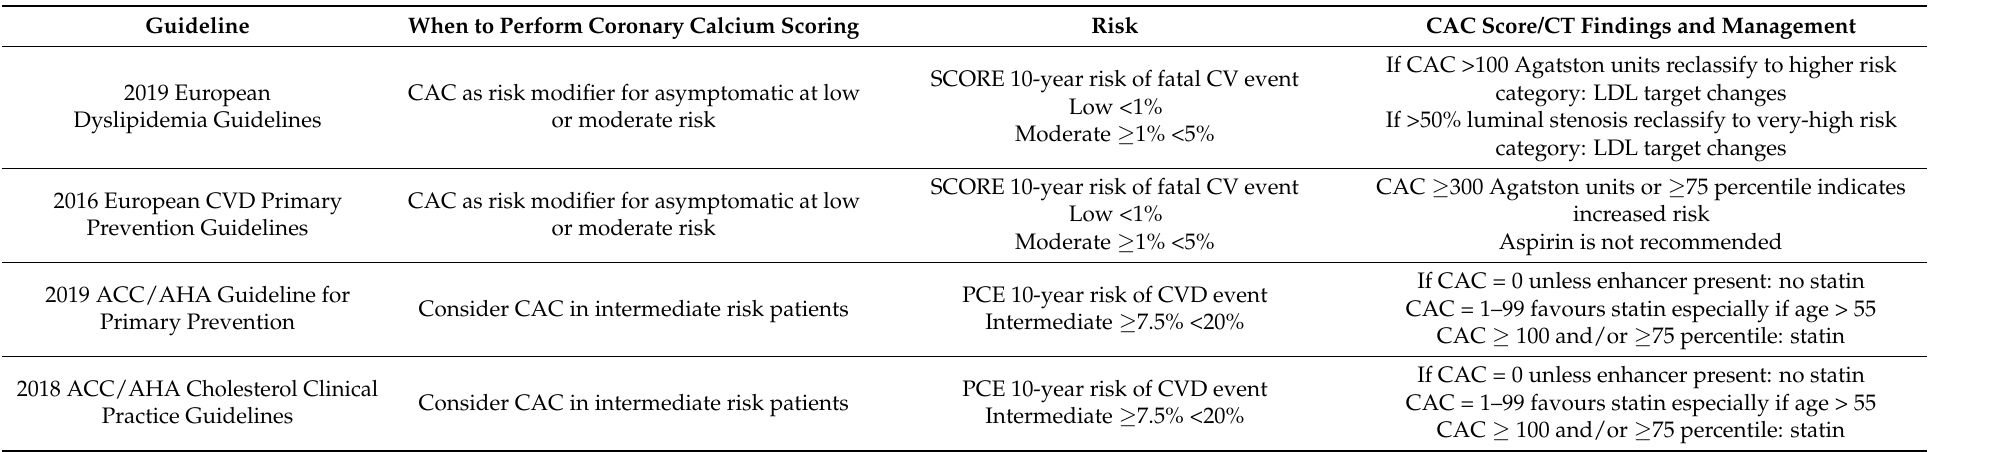
Table 1. European and American Societal guidelines for use of coronary artery calcium imaging (CAC) in primary prevention. European guidance is based on the SCORE clinical algorithm that predicts 10-years risk of fatal cardiovascular (CV) disease events. Whereas the American Heart Association/American College of Cardiology (AHA/ACC) guidelines use the Pooled Cohort Equations (PCE) 10 risk of a clinical CV